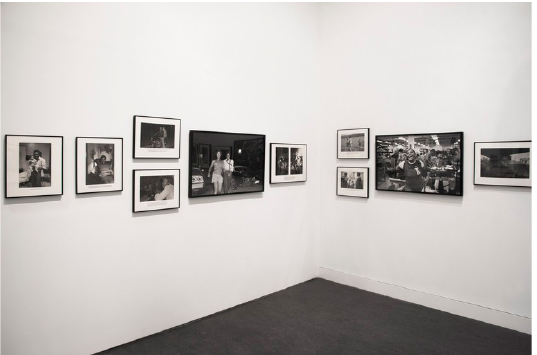
Figure 3 . Brooklyn Museum. Digital Collection and Services. We Wanted a Revolution: Black Radical Women , 1965-85. [04/21/2017-09/17/2017]. Installation view. Carrie Mae Weems, Family Pictures and Stories,